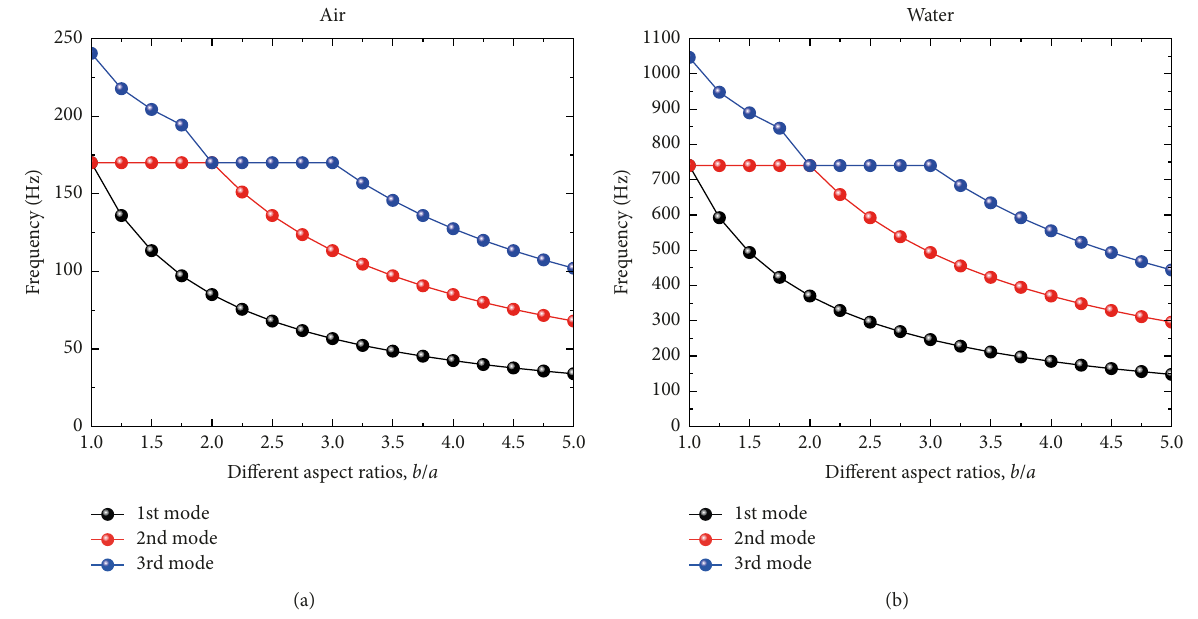
Figure 8: Variation of the frequency of the quadrangular prism acoustic cavity with various apex aspect